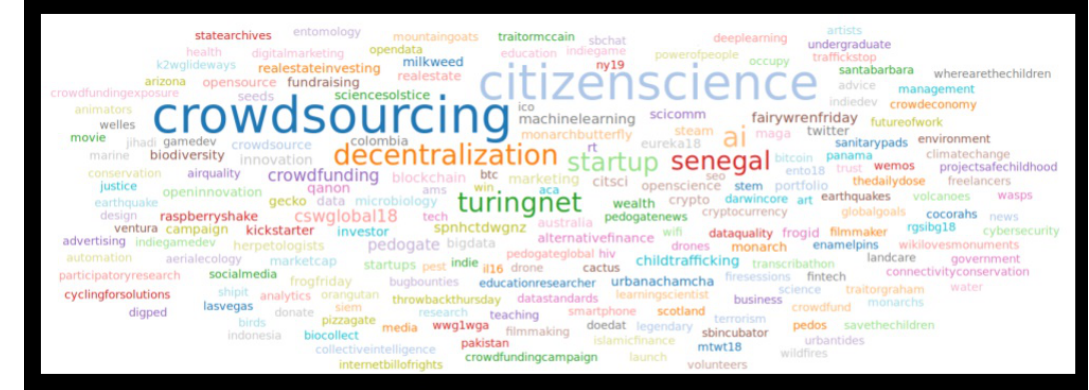
Figure 2. A tagcloud of hashtags from the Twitter